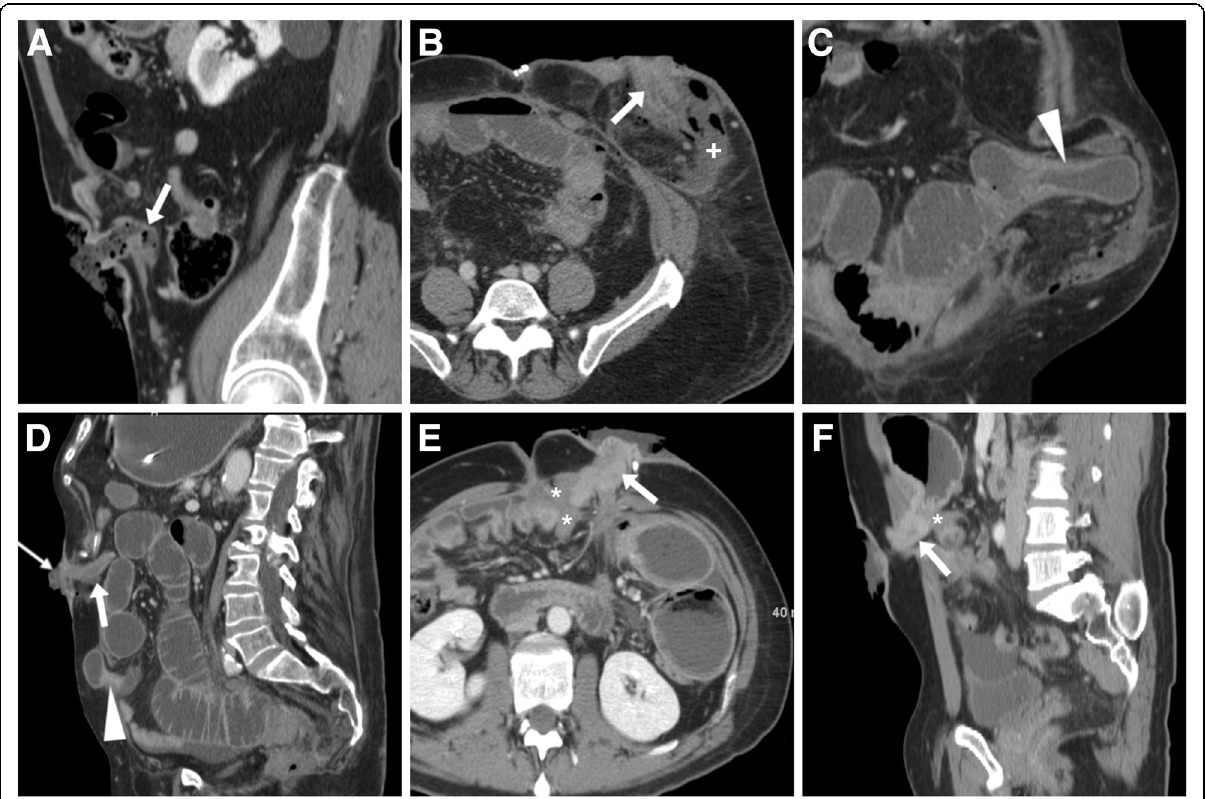
Fig. 16 Surgically confirmed obstructed stomas and alternative diagnoses. a Sagittal image showing sharply angulated stomal tract (arrow) causing upstream obstruction. b , c Entrapment with upstream dilatation of large bowel (arrowhead in c ) within a large PH in a patient with Crohn ’ s disease and permanent ileostomy (arrow in b ). Note peristomal fluid (+) and gas bubbles consistent with recent surgery. d Incisional hernia (arrowhead) causing obstruction, in a patient with uncomplicated ileostomy (arrow). e , f Blockage of ileostomy (arrow) from solid tissue (*) consistent with peritoneal